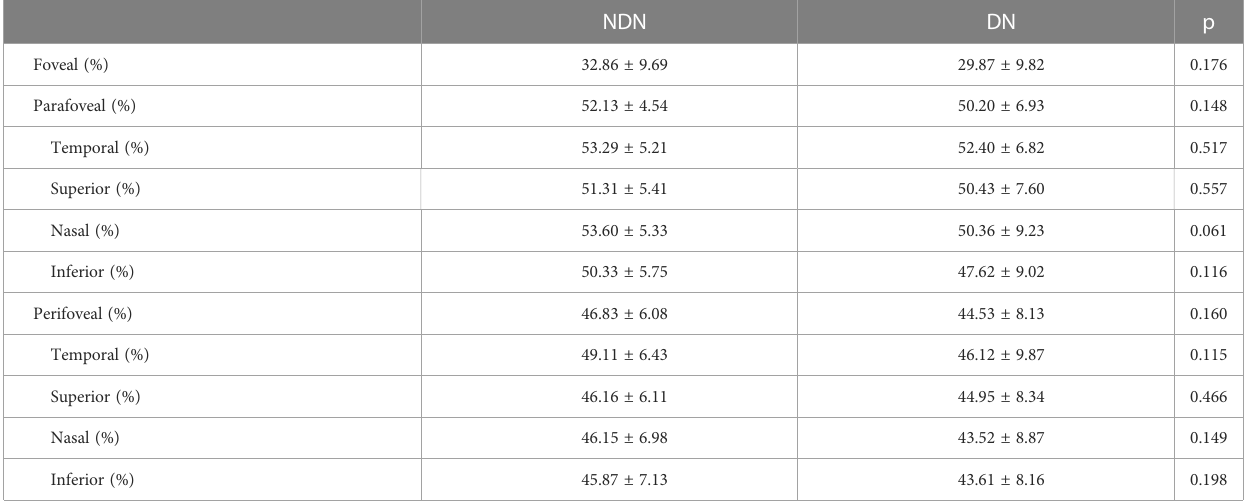
capillary density (whole area) and RNFL thickness (whole area) were included. Finally, the level of eGFR showed a signi fi cantly negative correlation with the FAZ area ( b = − 16.43, p=0.039) and a signi fi cantly positive correlation with the RNFL thickness ( b =0.169, p=0.025).